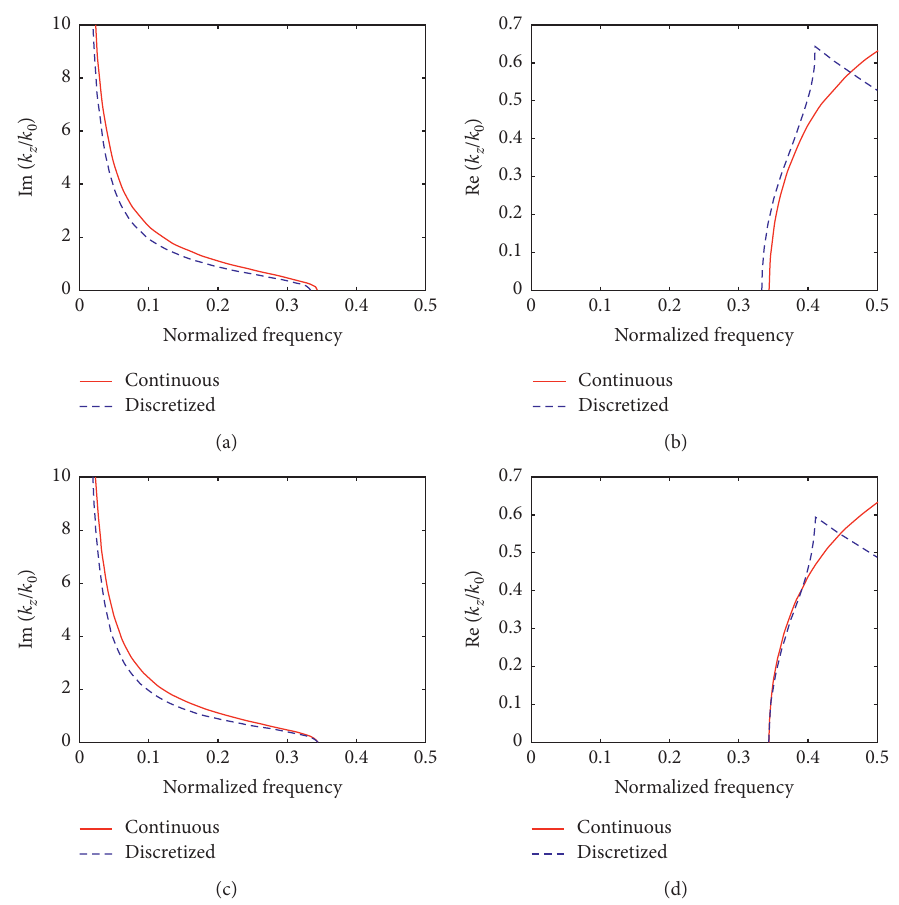
Figure 5: Imaginary and real parts of k values [(c) and (d)].